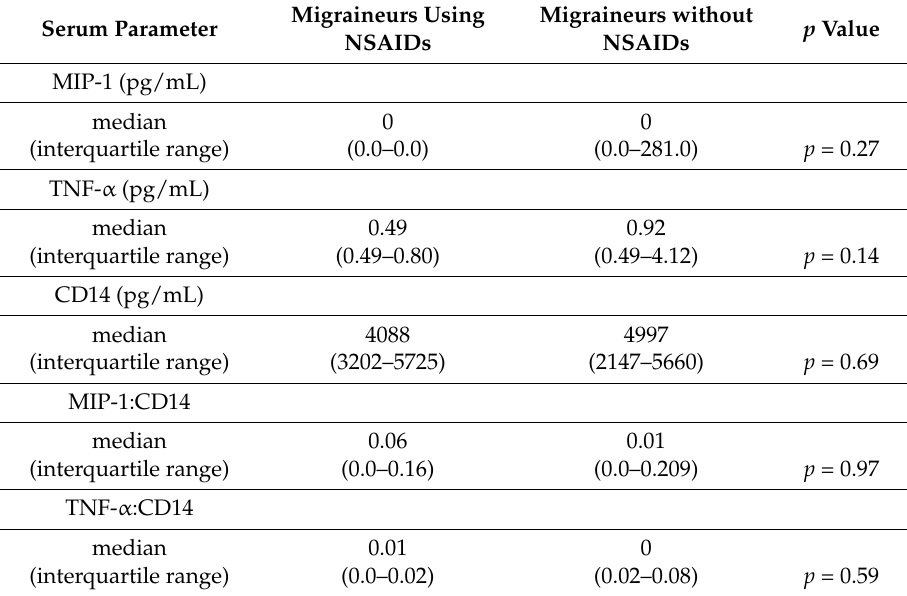
Table 5. Serum levels of MIP-1, TNF- α and CD14, TNF- α :CD14 and MIP-1:CD14 ratios in monocytes in migraine patients using and not using NSAIDs as abortive